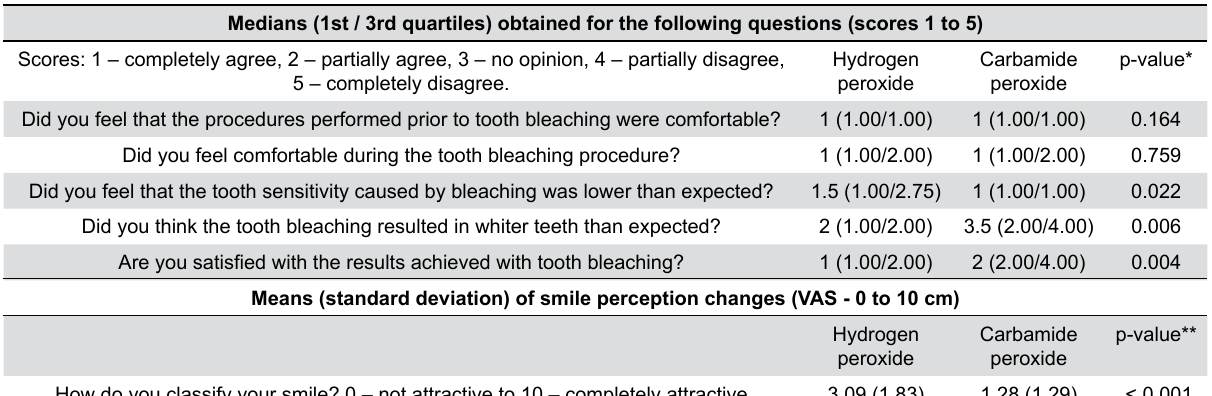
Table 2- Responses to questions evaluating patients’ perception of the tooth bleaching procedures performed